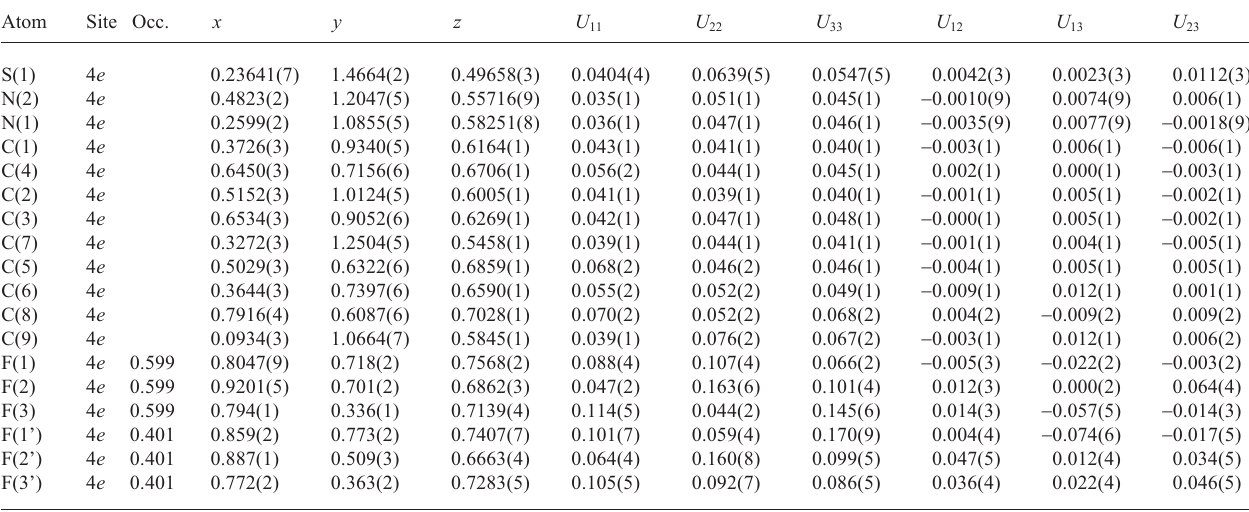
Table 3. Atomic coordinates and displacement parameters (in Å 2 ) . Atom Site